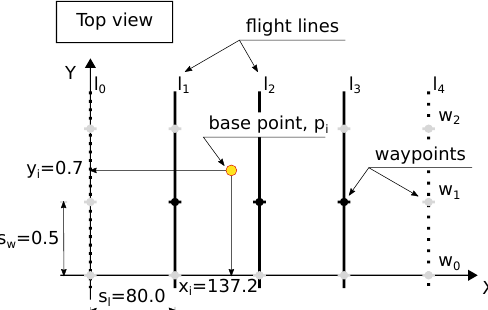
Figure 5. Mapping of base point to way points, where a base point pi is mapped to 3 flight lines l 1 , l 2 , l 3 before being mapped to the way points on the flight